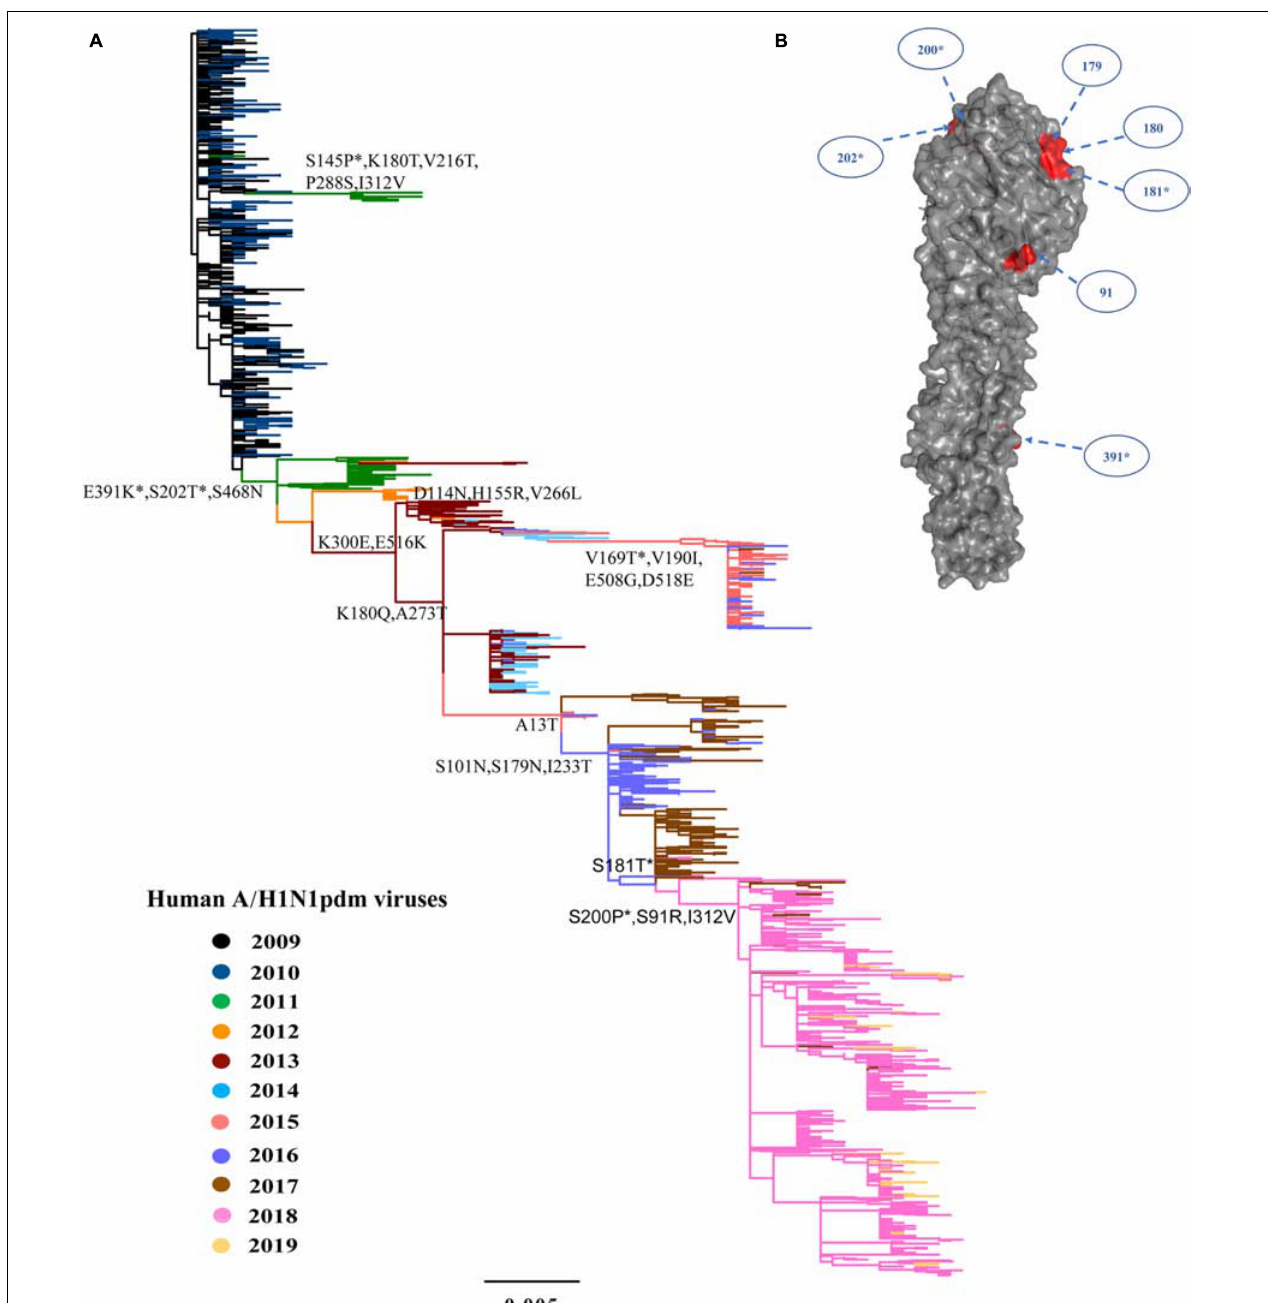
FIGURE 2 | Phylogeny of A/H1N1pdm virus by HA gene and three-dimensional structure of HA glycoprotein. (A) Maximum likelihood tree inferred from 1259 A/H1N1pdm virus HA sequences in China from 2009 to 2019. The color of the branch is marked by the isolation year of the strain. Fixed amino acid mutations are mapped at the major nodes of the tree. Positively selected sites are highlighted by asterisks (*). Scale bar represents number of substitutions per site. (B) Three-dimensional structure map of HA monomer of A/H1N1pdm virus (Protein Data Bank code: 3LZG). Antigenic sites were shown in red in the three-dimensional